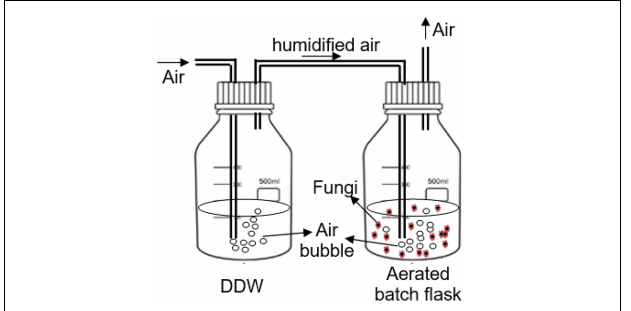
FIGURE 1 | Setup of the continuously aerated batch flasks